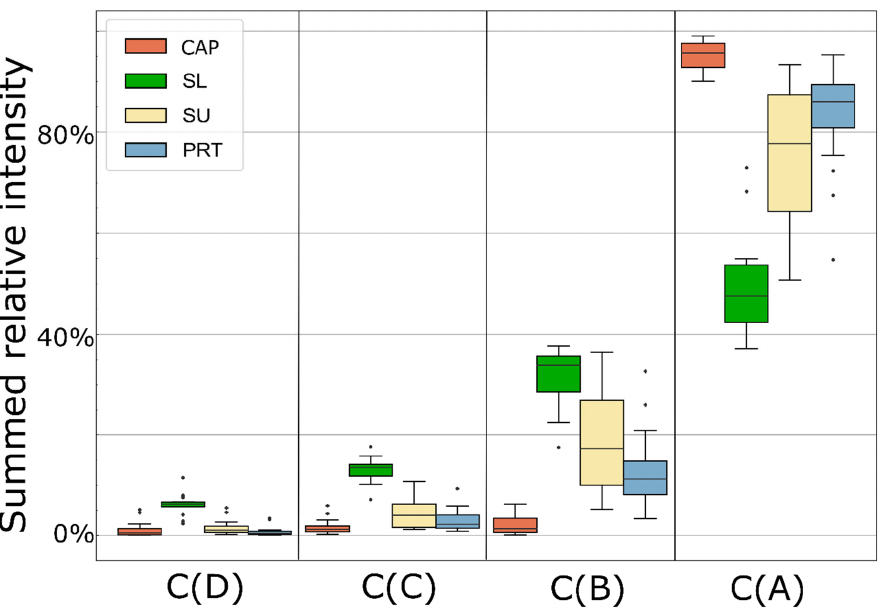
Figure 4. Boxplot of summed relative intensity of the four protein clusters in each sample type (n CAP = 18, n SL = 19, n SU = 20, n PRT = 20). (n CAP = 18, n SL = 19, n SU = 20, n PRT = The list, quantitative data, annotations, and cluster assignments of all proteins quan ‐ tified in the individual samples can be found in Table S2 in the Supplementary Materials.